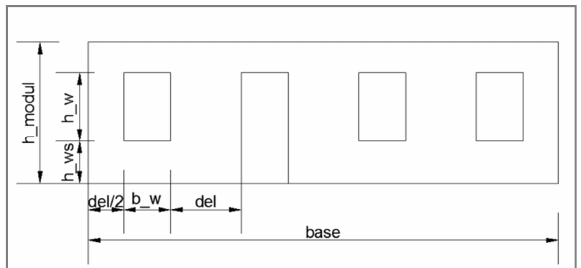
Figure 6. Basic module for the buildings and dimension value